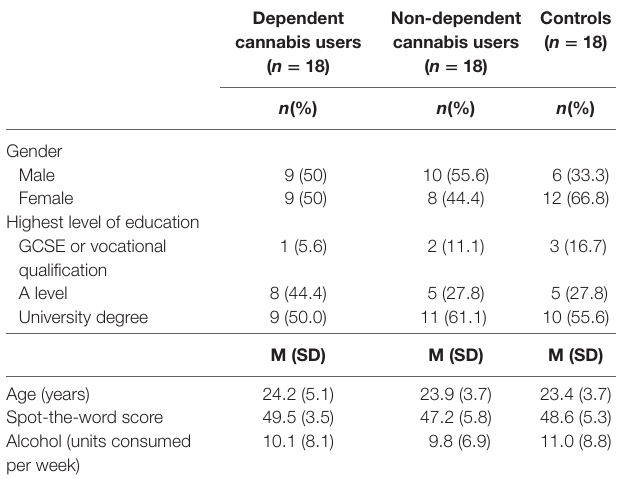
Table 1 | Group demographics, alcohol use, and spot-the-word scores across the dependent cannabis, non-dependent cannabis, and control groups.